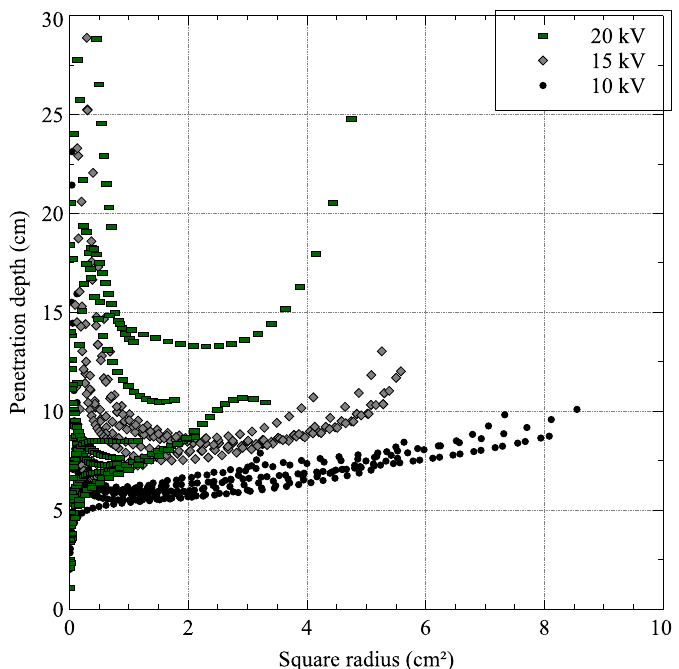
Figure 10. (Color online) penetration depth of platinum metal gas, also aggregated by charging